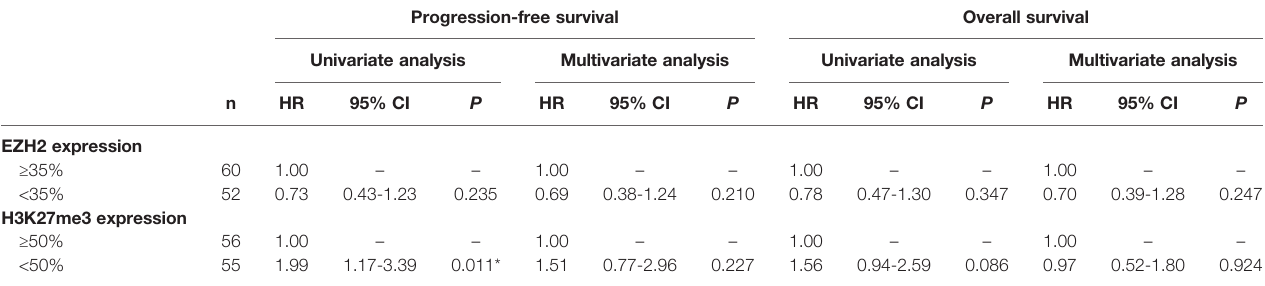
TABLE 3 | The association between EZH2 or H3K27me3 expression and clinical outcomes in patients with salivary duct carcinoma treated with conventional therapy. Progression-free survival Overall survival